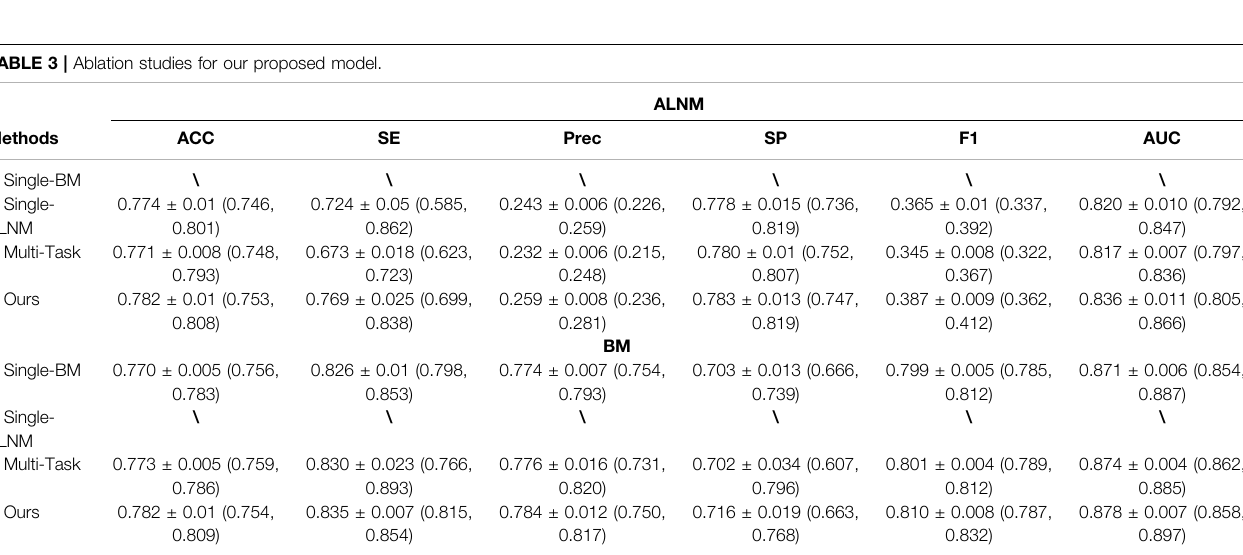
TABLE 3 | Ablation studies for our proposed